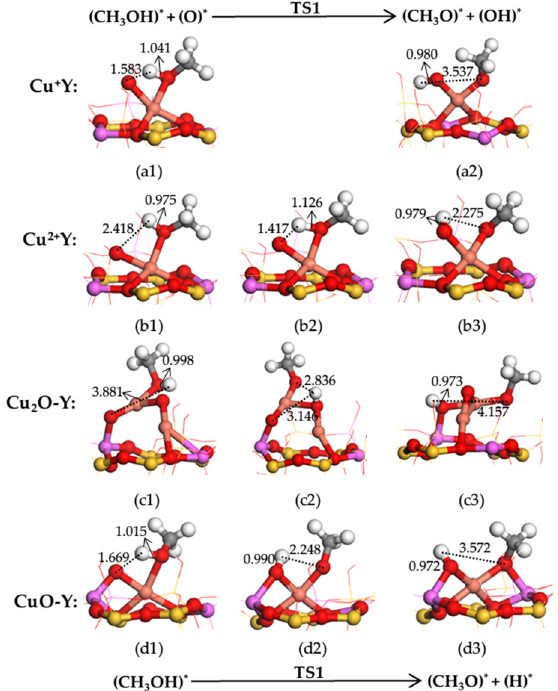
Figure 5. The structures of reactants, products and transition states on Cu + Y, Cu 2+ Y, Cu 2 O-Y and CuO-Y zeolite for the oxidation of CH 3 OH to CH 3 O (unit: Å). ( a1 ) (CH 3 OH) * /(O) * on Cu + Y, ( a2 ) (CH 3 O) * /(OH) * on Cu + Y, ( b1 ) (CH 3 OH) * /(O) * on Cu 2+ Y, ( b2 ) TS1 on Cu 2+ Y, ( b3 ) (CH 3 O) * /(OH) * on Cu 2+ Y, ( c1 ) (CH 3 OH) * /(O) * on Cu 2 O-Y, ( c2 ) TS1 on Cu 2 O-Y, ( c3 ) (CH 3 O) * /(OH) * on Cu 2 O-Y, ( d1 ) (CH 3 OH) * /(O) * on CuO-Y, ( d2 ) TS1 on CuO-Y and ( d3 ) (CH 3 O) * /(OH) * on CuO-Y. See Figure 4 for the color coding.